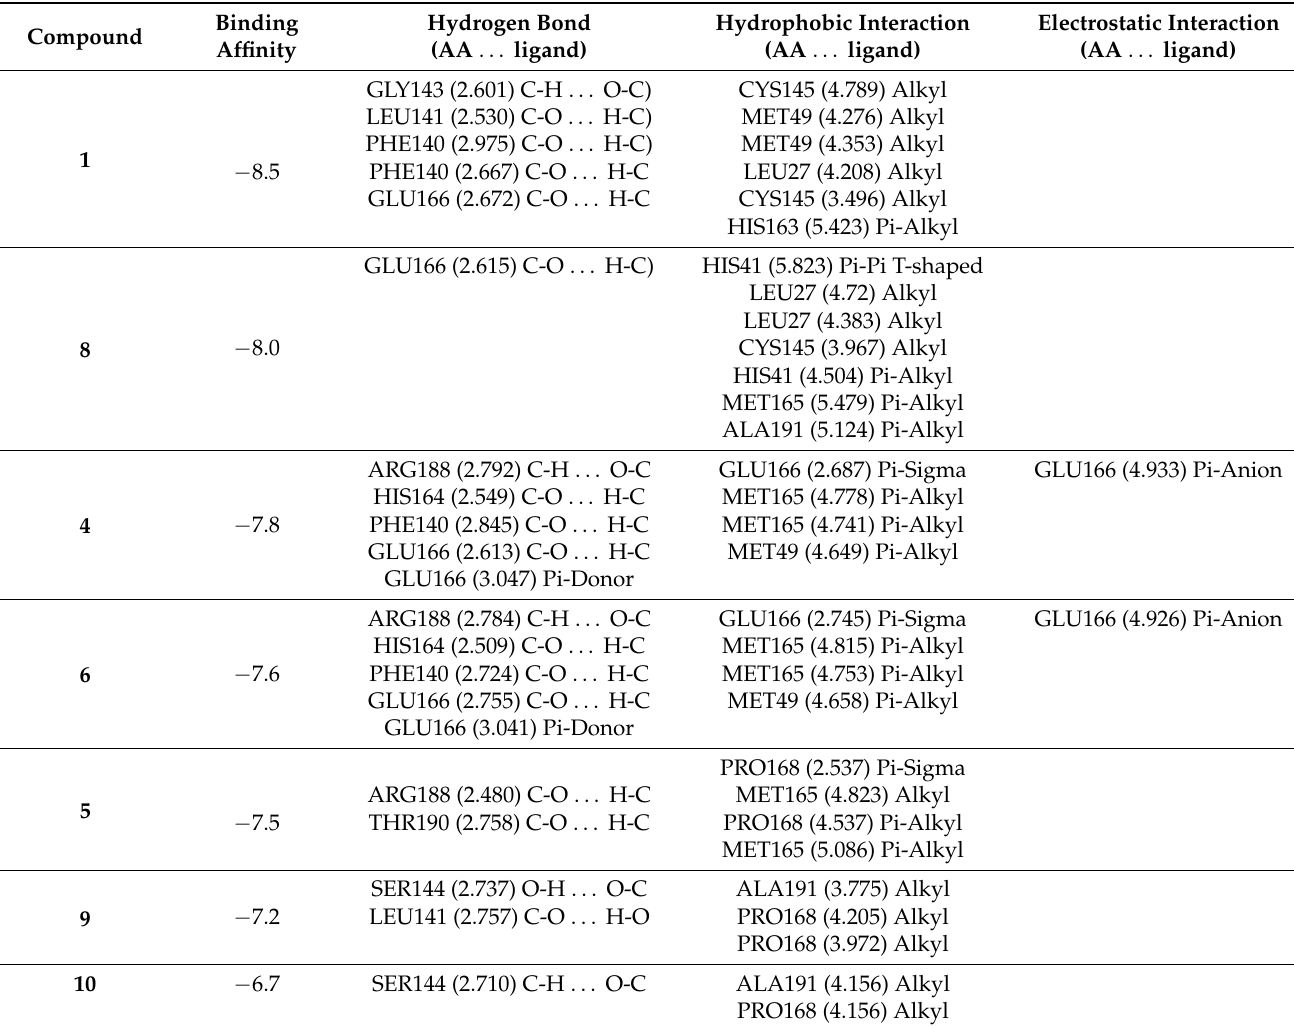
Table 3. Non-covalent interactions of isolated compounds with Mpro (PDB ID 6LU7) (Pose predicted by AutoDock